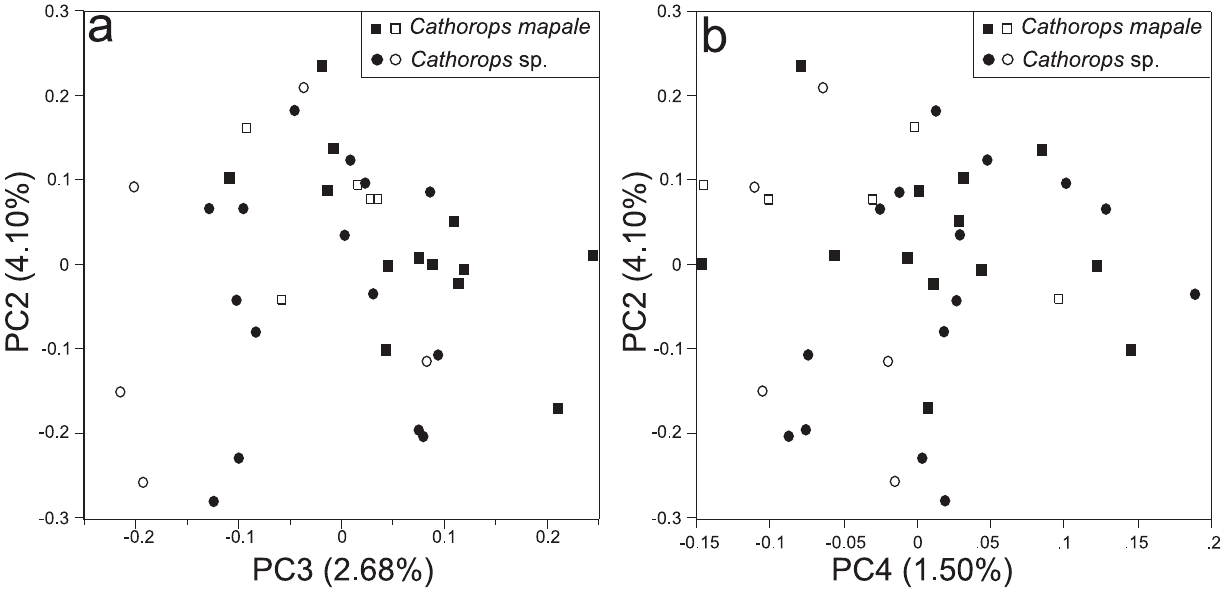
Figure 3. Principal component analysis of 35 morphometric variables from the Cathoropsmapale group. Scatterplots of (A) PC2 vs. PC3 and (B) PC2 vs. PC4 (percent of variation for each PC given in parenthesis). Opened and filled symbols represent males and females, respectively.